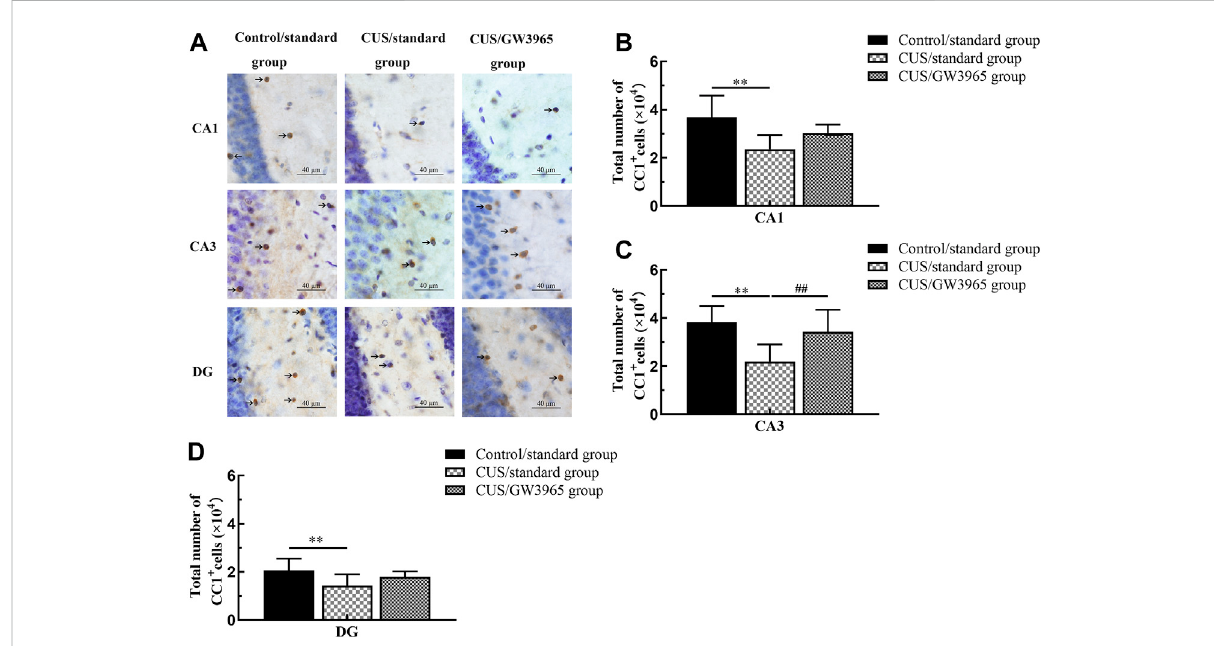
FIGURE 3 Illustration of CC1 + cell density. (A) Representative images of immunohistochemical staining of CC1 + cells in the CA1, CA3 and DG areas of the hippocampusintheControl/standardgroup,theCUS/standardgroupandtheCUS/GW3965group.ThearrowsindicateCC1 + cells.Bar=40 μ m. (B) Comparisonsof theCC1 + cell numbersin CA1 region among theControl/standard group, theCUS/standardgroup and theCUS/GW3965 group. (C) Comparisons of the CC1 + cell numbers in CA3 region among the Control/standard group, the CUS/standard group and the CUS/ GW3965 group. (D) Comparisons ofthe CC1 + cell numbers in DG region among the Control/standard group, theCUS/standard group and theCUS/ GW3965 group. pp indicates p < 0.05 for the CUS/standard group compared with the Control/standard group. ## indicates p < 0.05 for the CUS/ standard group compared with the CUS/GW3965 group. All the data are shown as the means ±